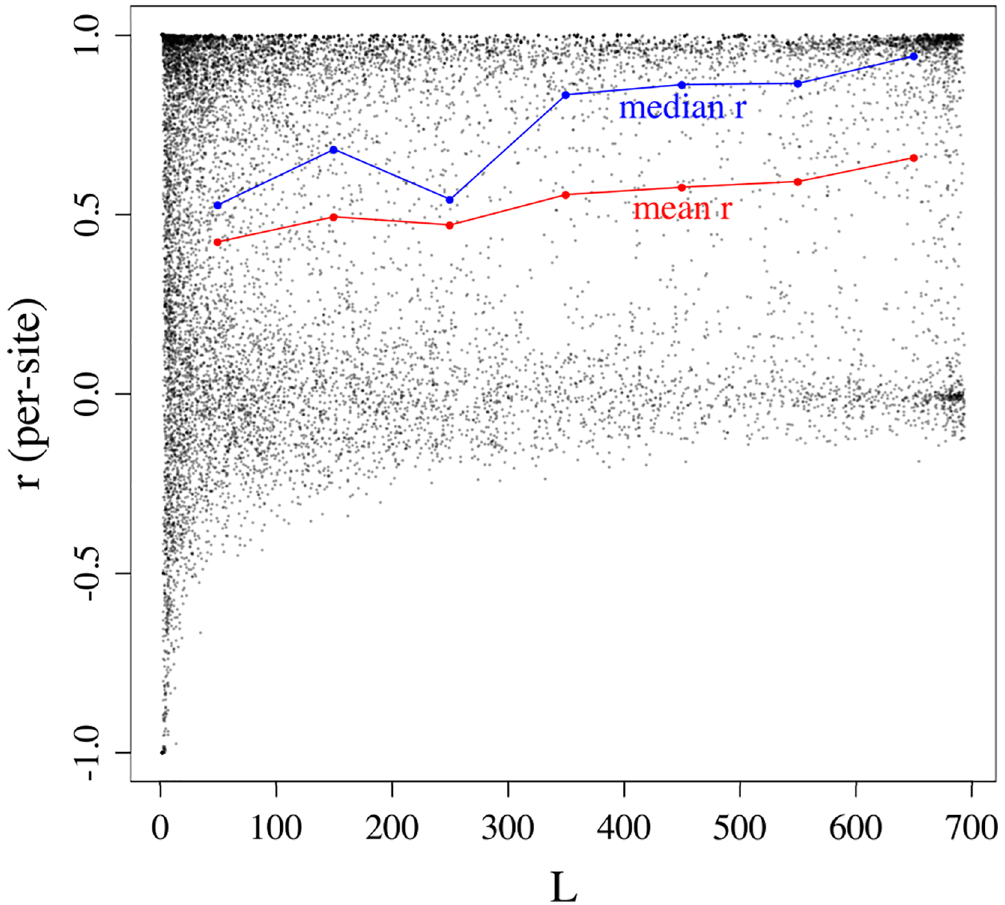
Fig 1. Estimates of accuracy as a function of L for 13028 sites imputed with Beagle. Imputation accuracies were estimated using the sample Pearson correlation coefficient, r . The sample Pearson correlation is a function of two vectors, both of length L . Fig 1. presents estimated accuracy as a function of L for set A sites ( n = 13028). The range of L is divided into a series of seven equally sized bins (i.e. 0 < L (cid:4) 100 , 100 < L (cid:4) 200 , ... , 600 < L (cid:4) 700 ). Accuracy estimates were divided into bins according to their corresponding values of L . Bin means and medians are presented as red and blue points,